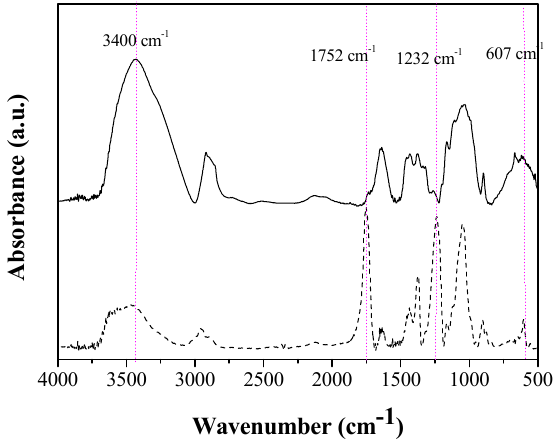
Figure 2. Infrared spectrum obtained for Kraft pulp (straight line) and cellulose triacetate (dashed line).